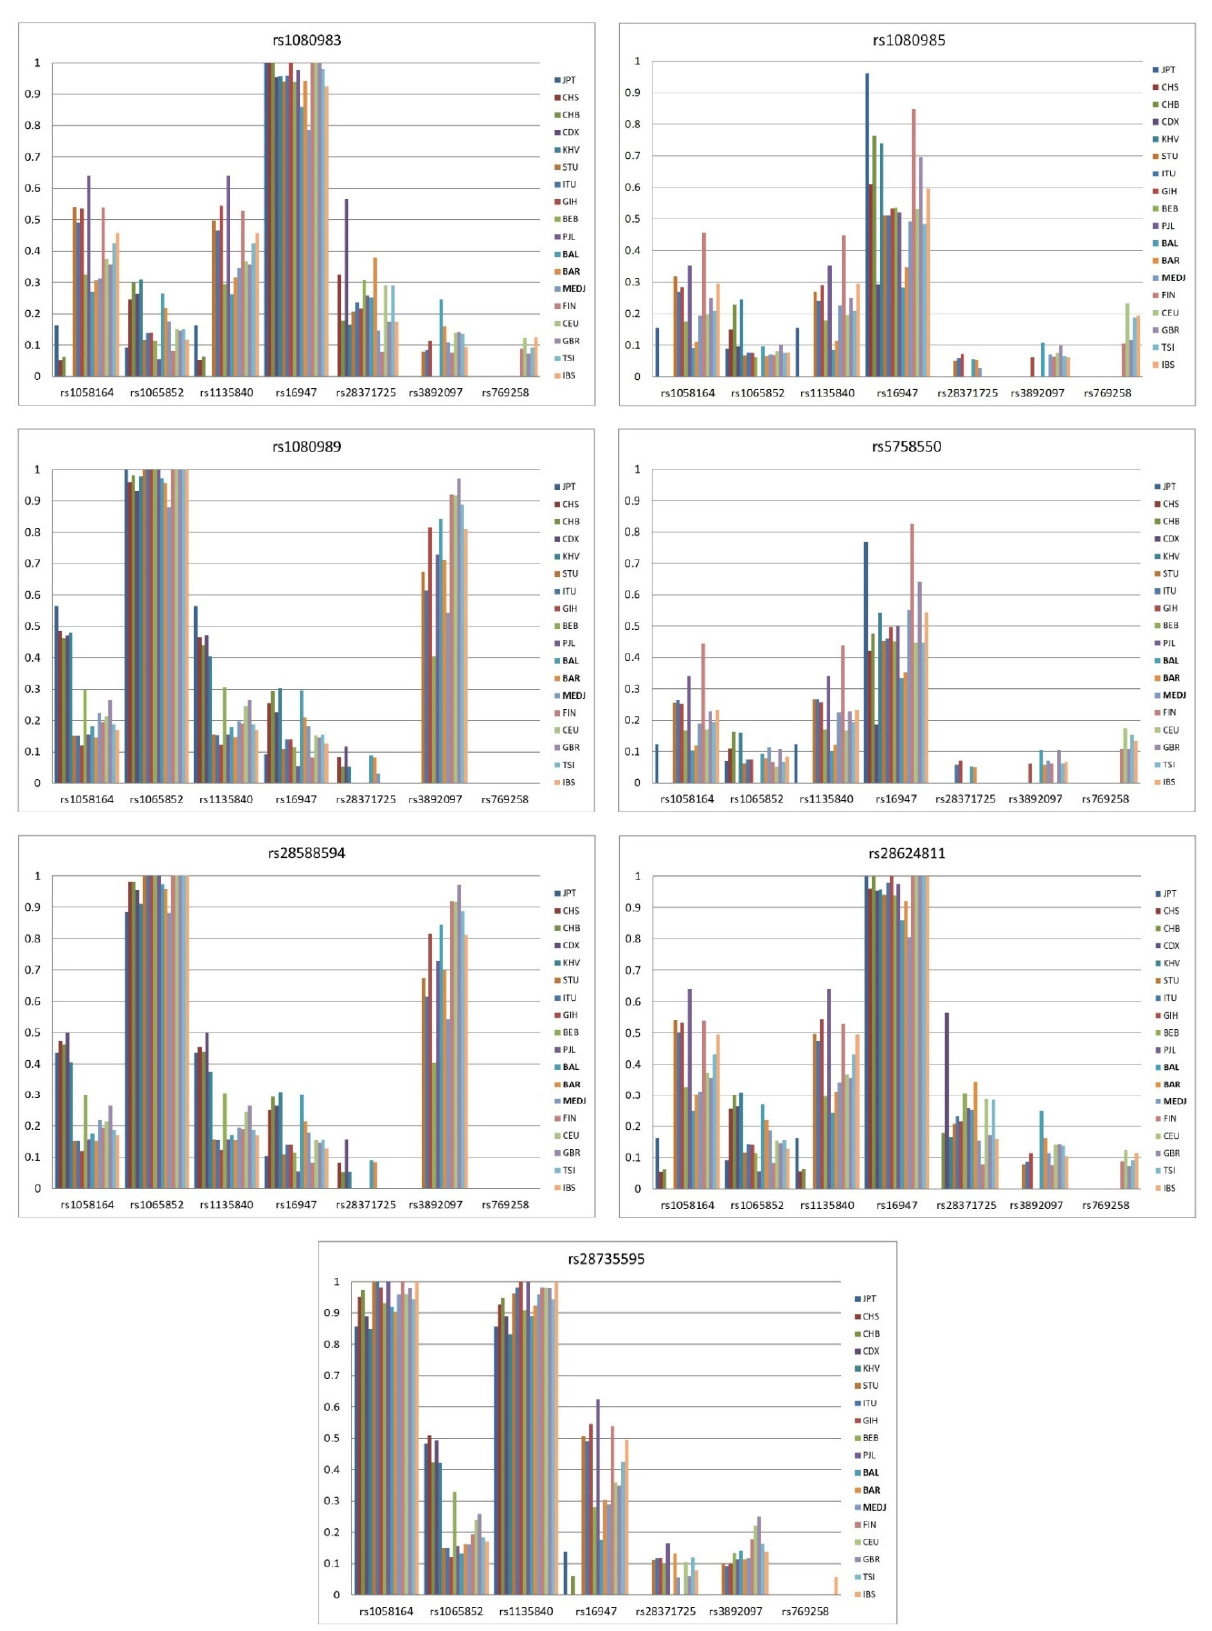
Figure 1. LD values’ (r 2 ) distribution between the CYP2D6 promoter and enhancer SNPs and star allele-defining SNPs in the European, South Asian, East Asian and Croatian Roma populations.